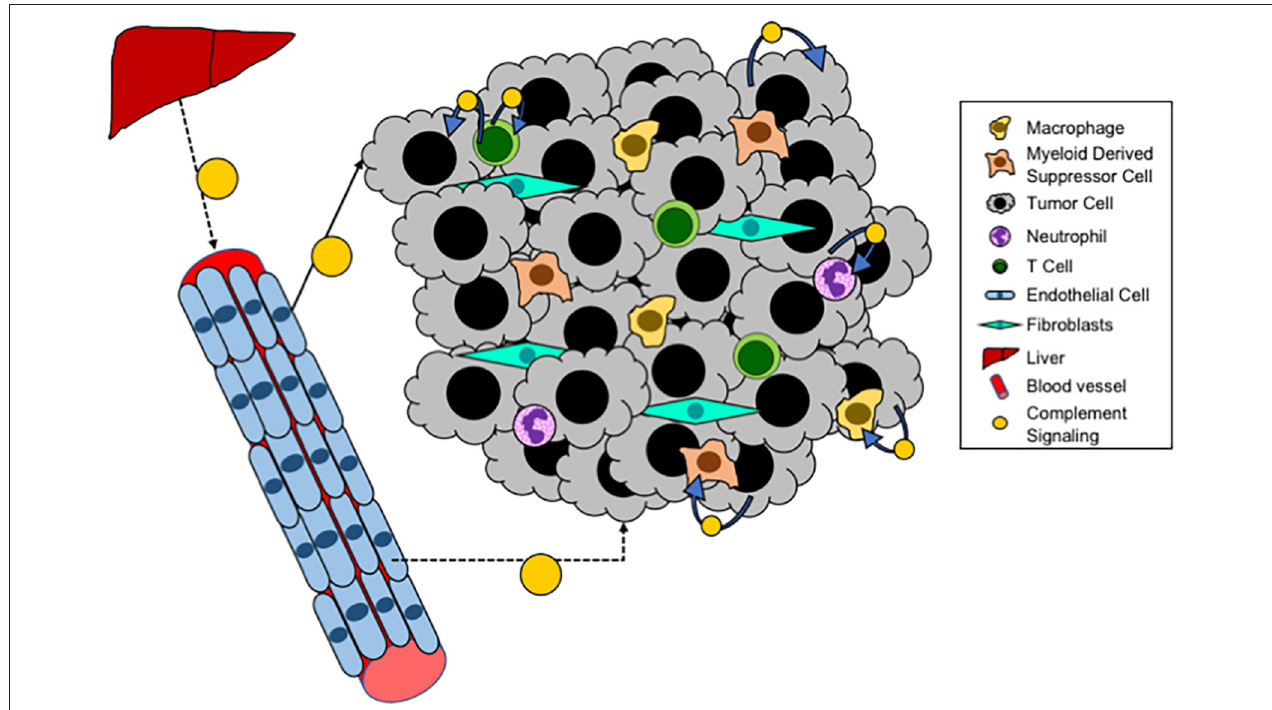
FIGURE 3 | Local complement signaling in tumors. A schematic of complement signaling that occurs within tumors. Systemic complement is produced by the liver and travels via the blood to distant sites. While locally, within a tumor, tumor cells, T cells, and endothelial cells can all produce complement that acts either in an autocrine or paracrine